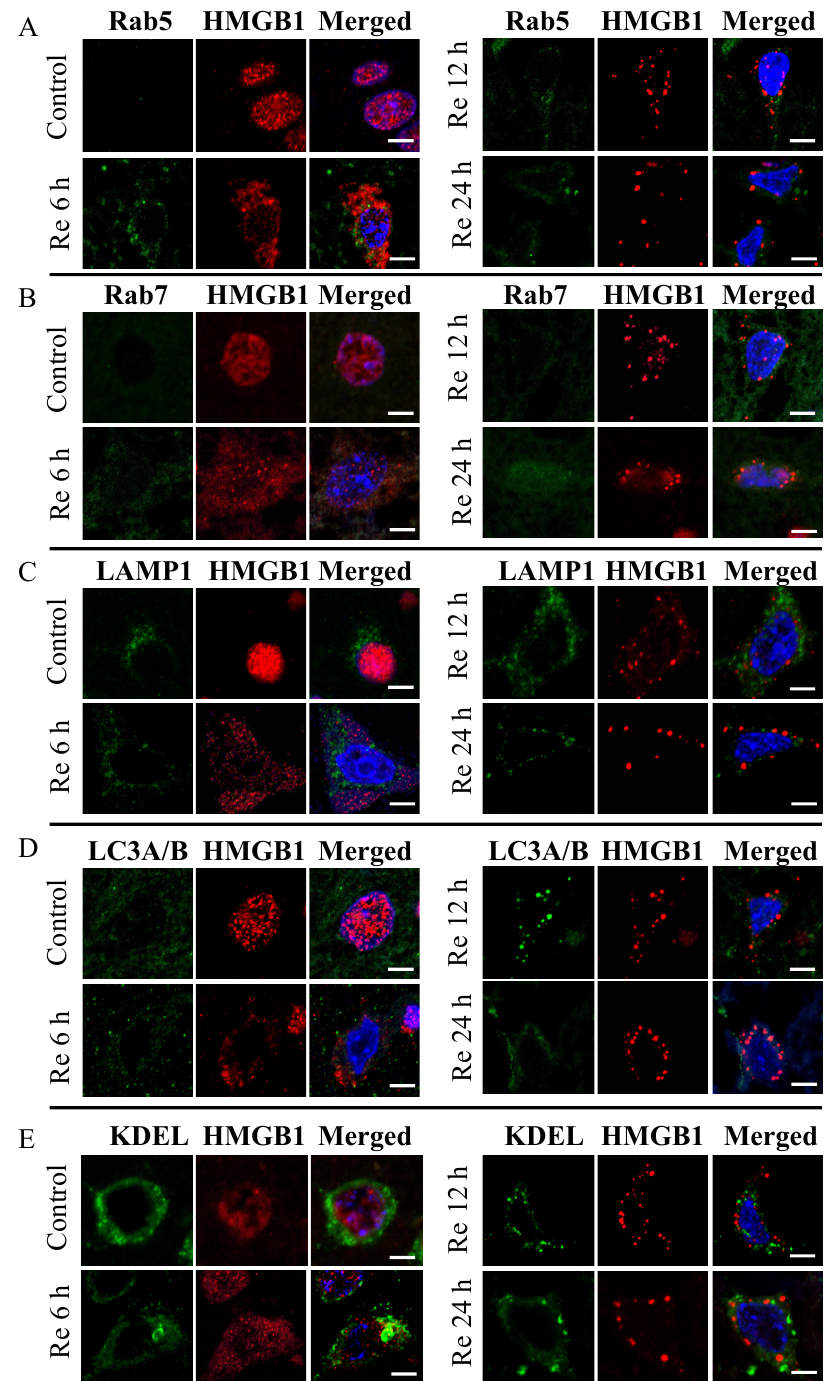
Figure 2. Immunostaining of HMGB1 with Rab5, Rab7, LAMP1, LC3A / B, and KDEL visualized with a confocal laser-scanning microscope. Coronal sections were prepared in control brain (sham group) and at 6,12, and 24 h after reperfusion. ( A ) Staining for HMGB1 (red) and Rab5 (green) was observed in the control brain, 6, 12, and 24 h after reperfusion. ( B ) Staining for HMGB1 (red) and Rab7 (green) was observed in the control brain, 6, 12, and 24 h after reperfusion. ( C ) Staining for HMGB1 (red) and LAMP1 (green) was observed in the control brain, 6, 12, and 24 h after reperfusion. ( D ) Staining for HMGB1 (red) and LC3A / B (green) was observed in the control brain, 6, 12, and 24 h after reperfusion. ( E ) Staining for HMGB1 (red) and KDEL (green) was observed in the control brain, 6, 12, and 24 h after reperfusion. Scale bar: 5 µ